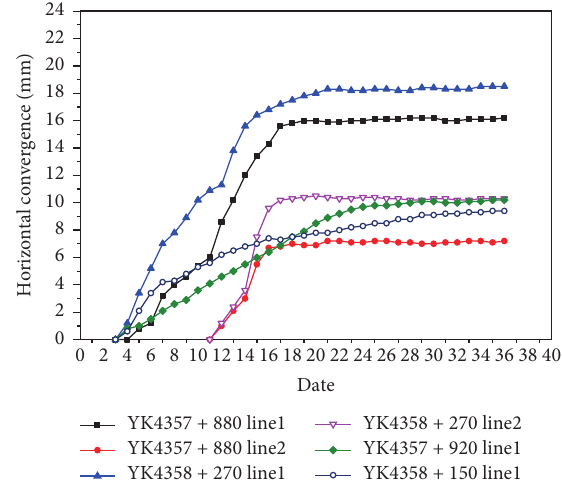
Figure 17: Horizontal convergence development